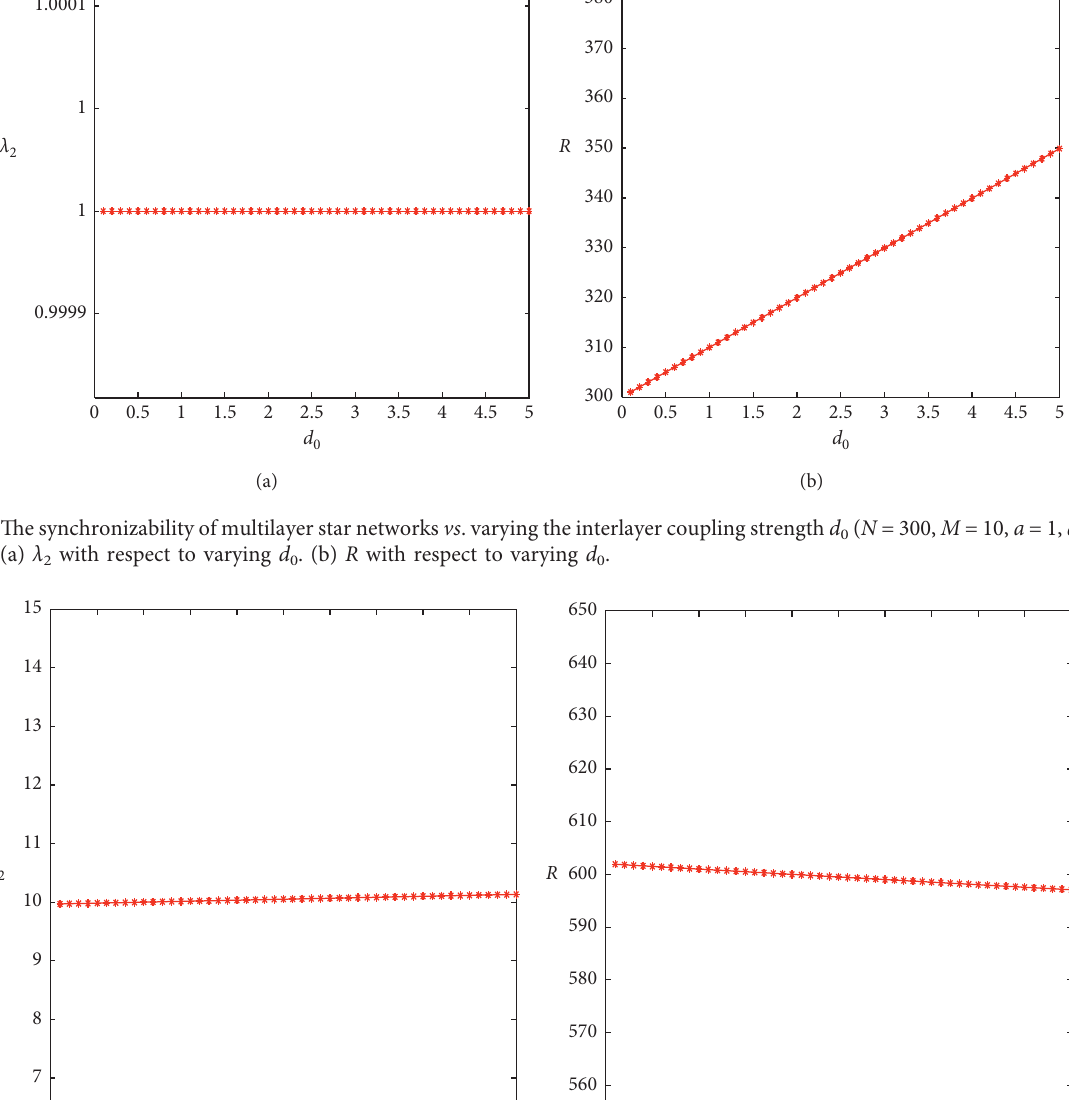
� 300, M � 10, a � 20, d � 1, 0 ( N